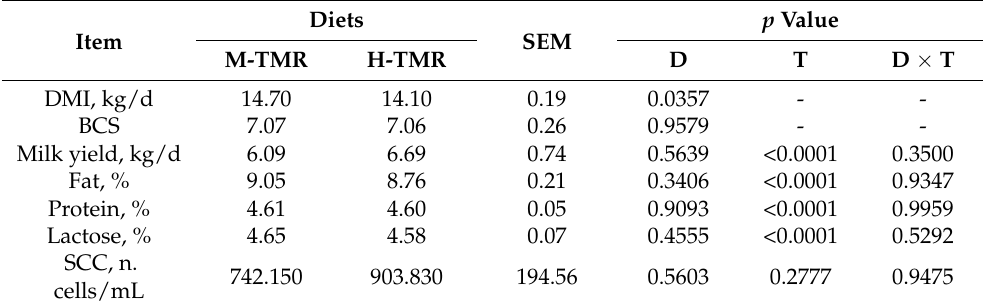
Table 4. Dry matter intake, body condition score, milk yield, and quality (LSM) of buffaloes fed total mixed ration based on maize silage (M-TMR) and hay (H-TMR).